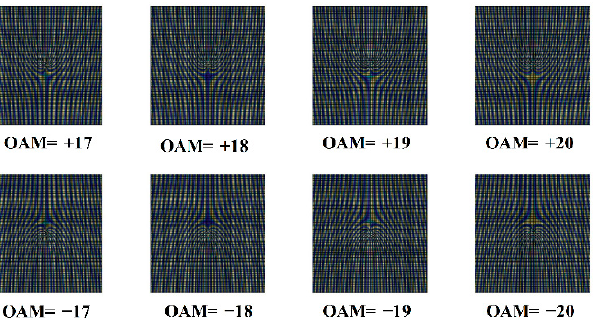
Figure 5. Light intensity distribution of a similar multi-mode OAM beam.